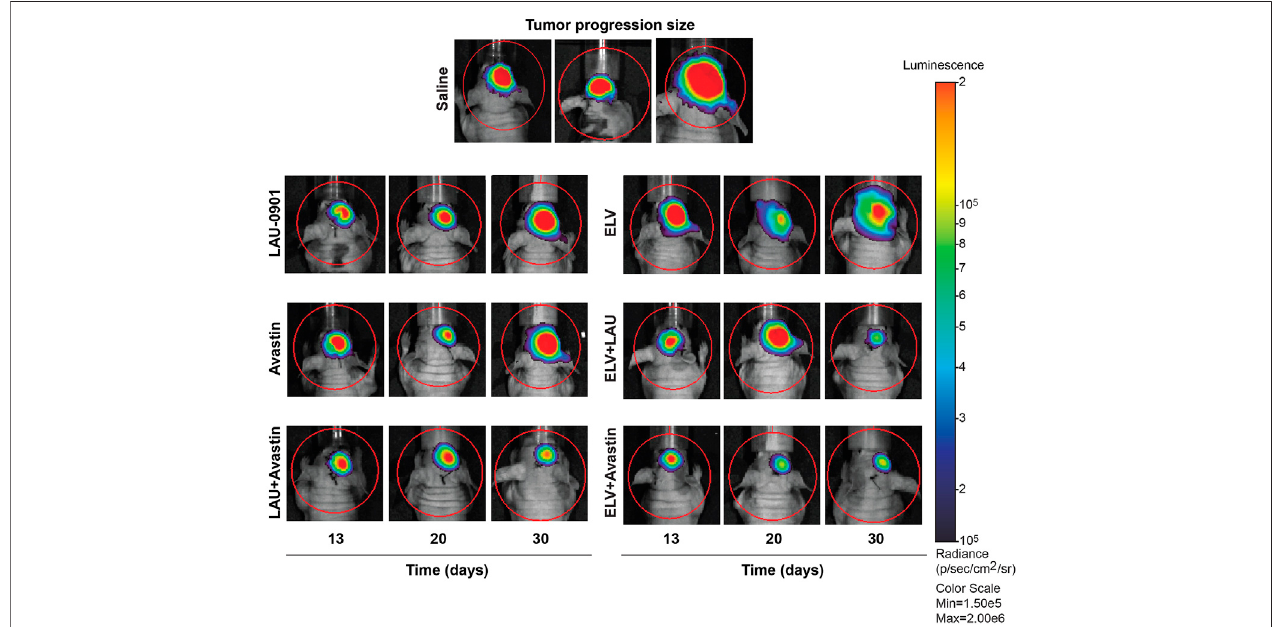
FIGURE 4 | Representative bioluminescent images of the brain tumors from all experimental groups. Mice received treatment on day 13, and tumor growth progressionwasmonitoredondays13,20,and30afterimplantation.Theintensityoflightemissionisindicatedbyacolorimetricscale,whereredrepresentsthehighest amount of light emission, and blue/violet shows the least. There was progressive and rapid tumor growth in the saline group. In contrast, LAU-0901, Avastin, ELV, and combination repress orthotopic GBM.